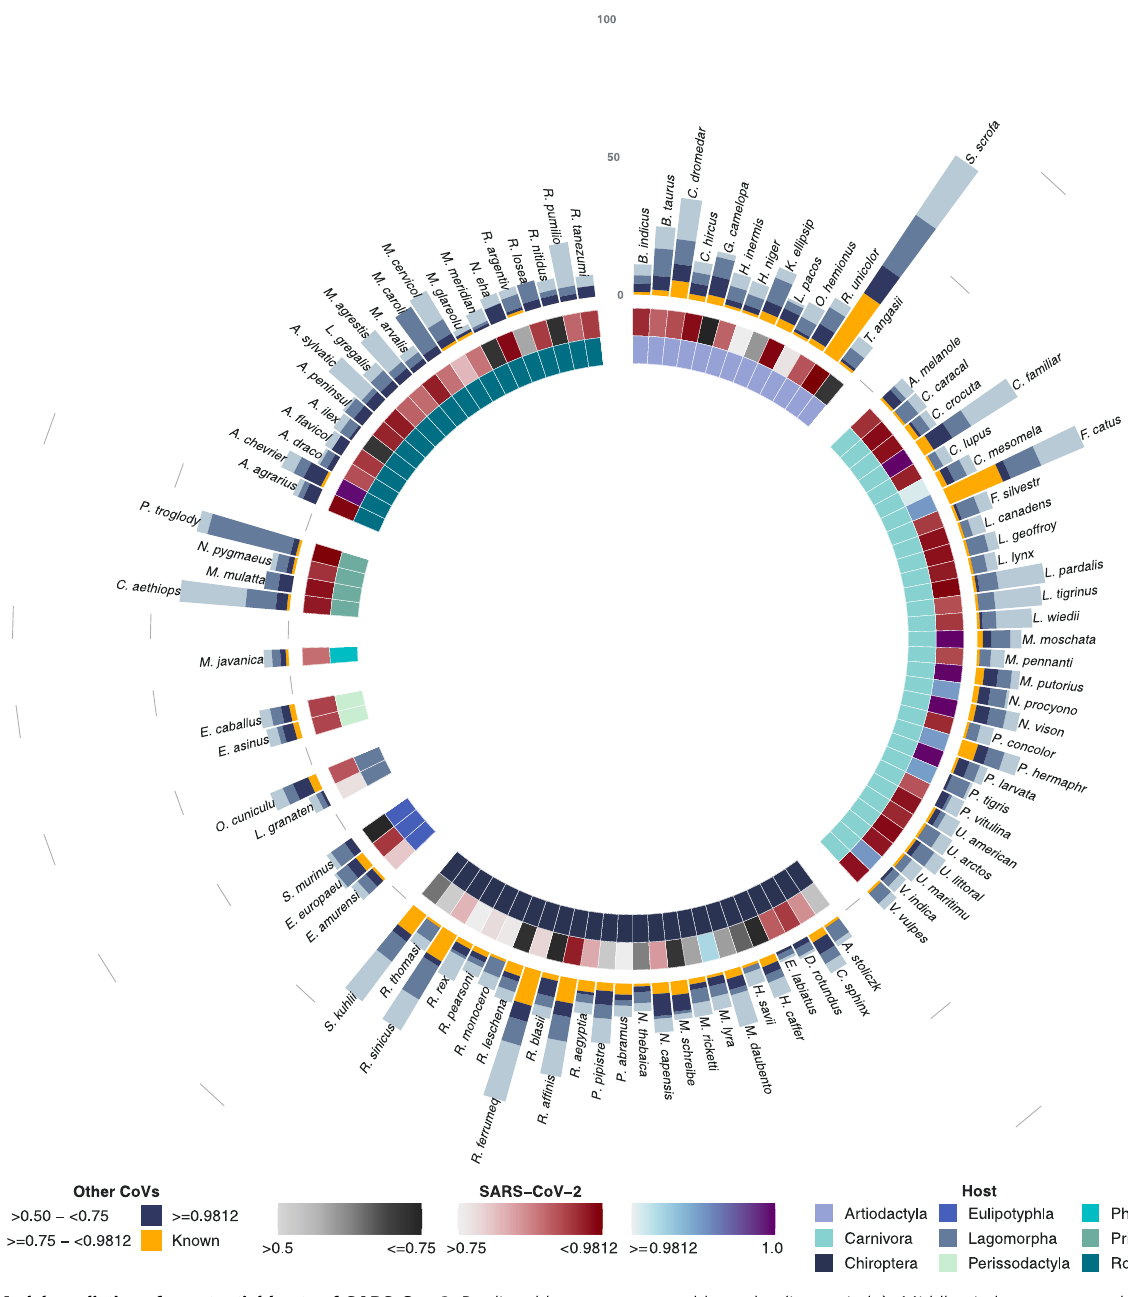
Fig. 1 Model predictions for potential hosts of SARS-Cov-2. Predicted hosts are grouped by order (inner circle). Middle circle presents probability of association between host and SARS-CoV-2 (grey scale indicates predicted associations with probability in range > 0.5 to ≤ 0.75. Red scale indicates predicted associations with probability in range > 0.75 to <0.9821. Blue to purple scale present indicates associations with probability ≥ 0.9821). Yellow bars represent number of coronaviruses (species or strains) observed to be found in each host. Blue stacked bars represent other coronaviruses predicted to be found in each host by our model. Predicted coronaviruses per host are grouped by prediction probability into three categories (from inside to outside): ≥ 0.9821, >0.75 to <0.9821 and >0.5 to ≤ 0.75. Results for humans and lab rodents are not shown to prevent the scale from contracting